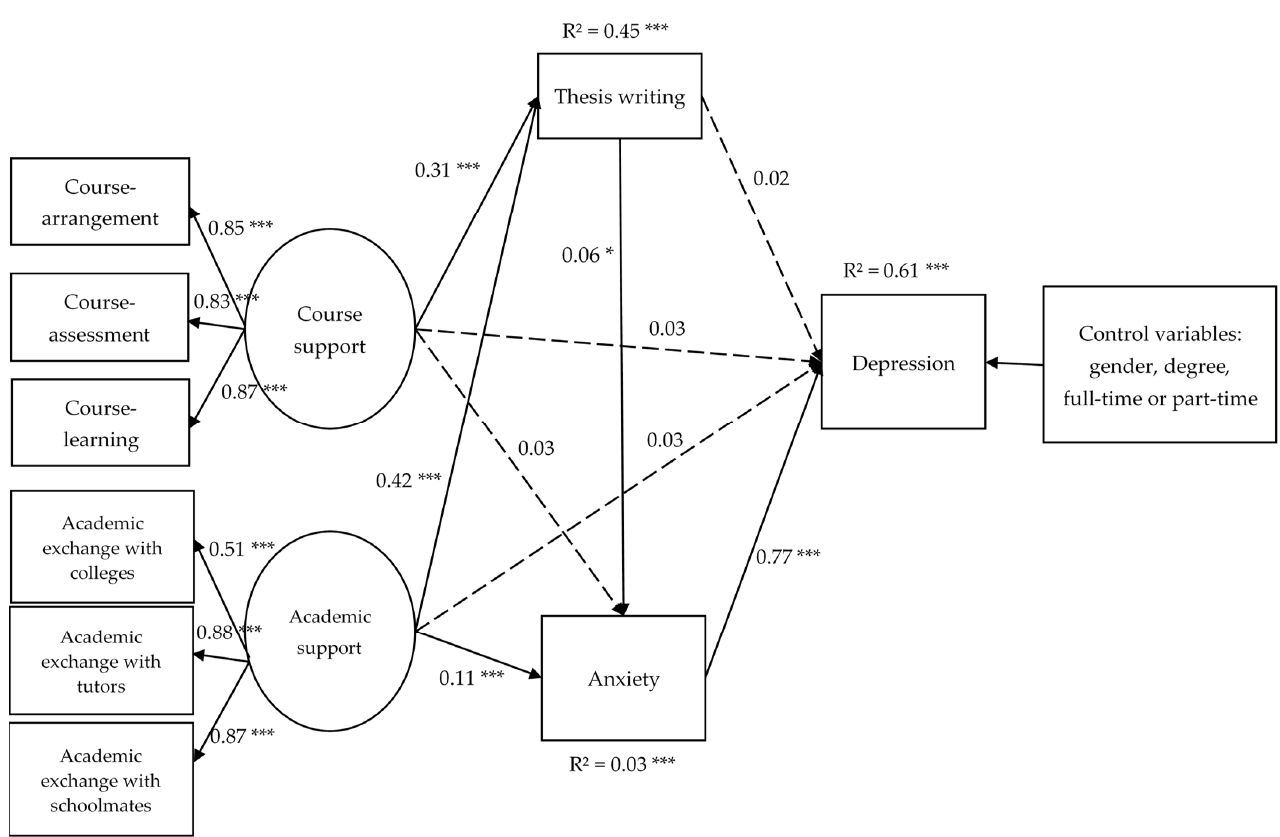
Figure 2. Standardized path coefficients for the mediation model linking Course support and Academic support to post-graduate students depression. Note: Solid lines represent significant paths. Dotted lines represent non-significant path. N = 3137; * p < 0.05, *** p < 0.001.